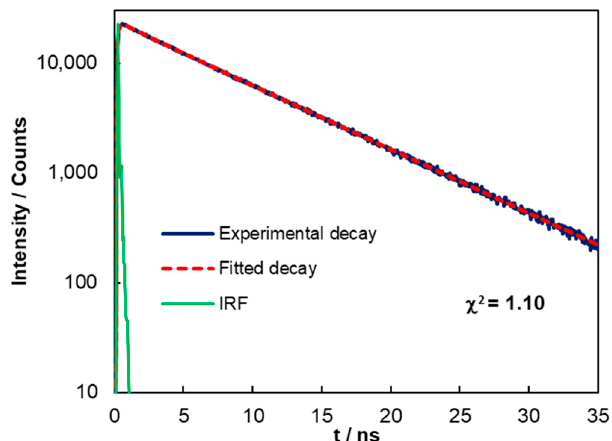
Figure 2. Time-resolved intensity decay of bis-calixarene-3,6-CBZ ( 4 ) in toluene obtained by the single-photon timing method under excitation at 340 Figure 2. Time ‐ resolved intensity decay of bis ‐ calixarene ‐ 3,6 ‐ CBZ ( 4 ) in toluene obtained by the single ‐ photon timing method under excitation at 340 nm.